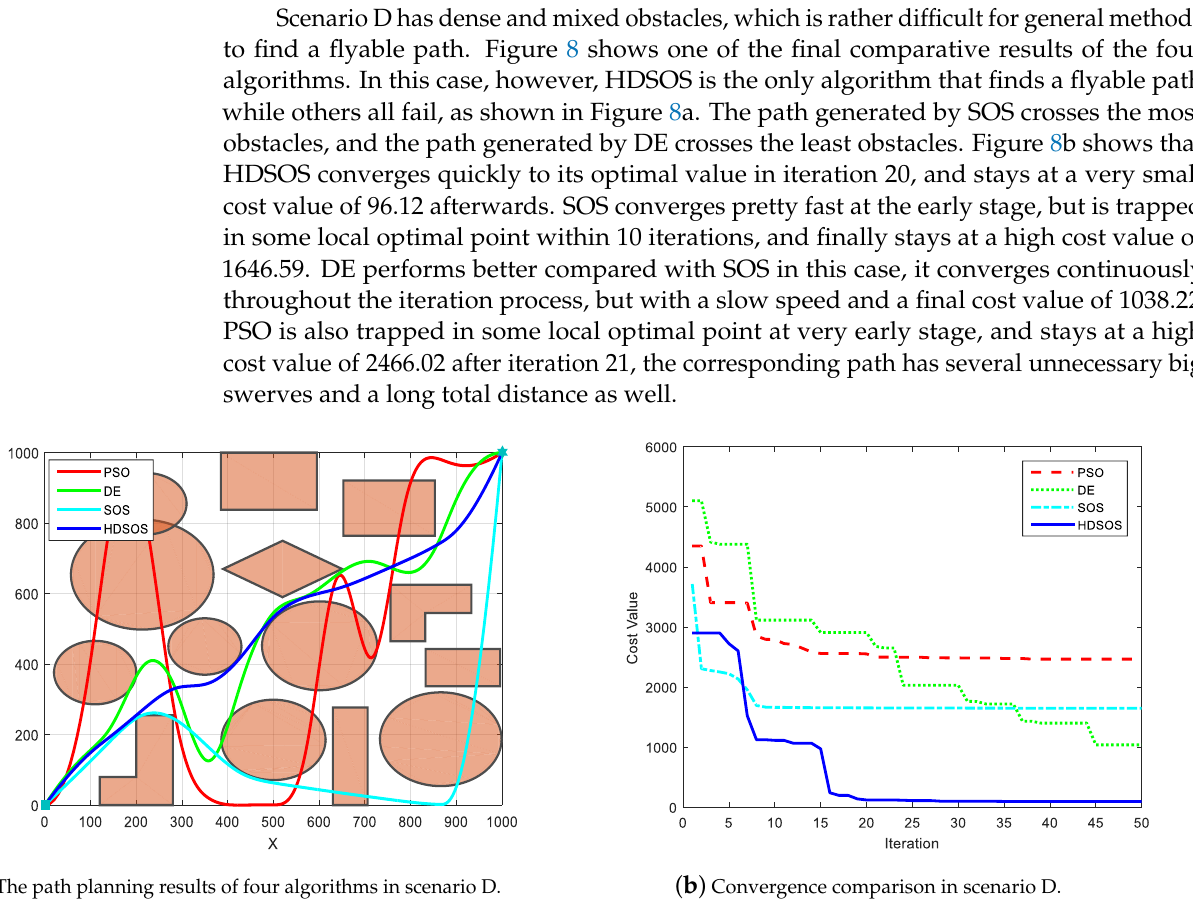
Figure 7. The comparative results for two-dimensional scenario C.